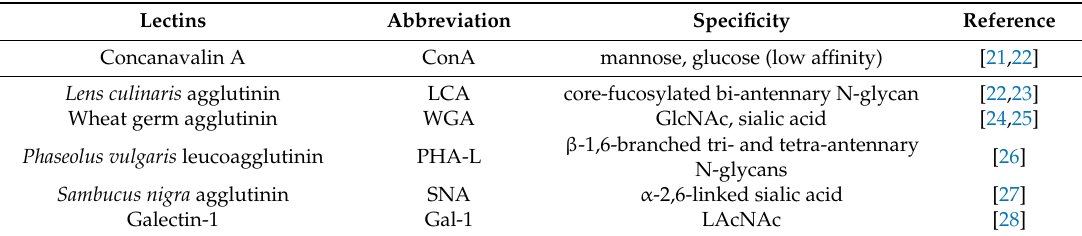
Table 1. Names, abbreviations, and binding specificities of